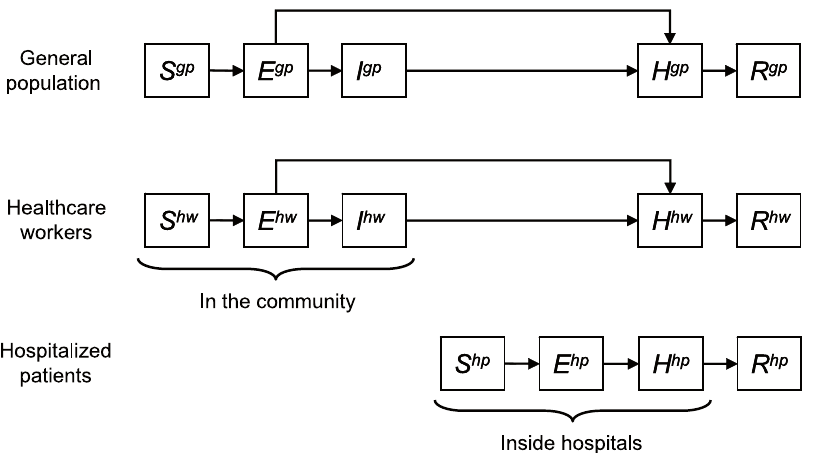
Figure 1. Compartmental Model for SARS Transmission in Hong Kong. Superscript letters denote social categories: gp , general population; hw , healthcare workers; hp , hospitalized patients. Disease states are: S , susceptible; E , exposed (infected but not yet infectious); I , infectious not hospitalized; H , infectious hospitalized, and R , removed (recovered or dead).